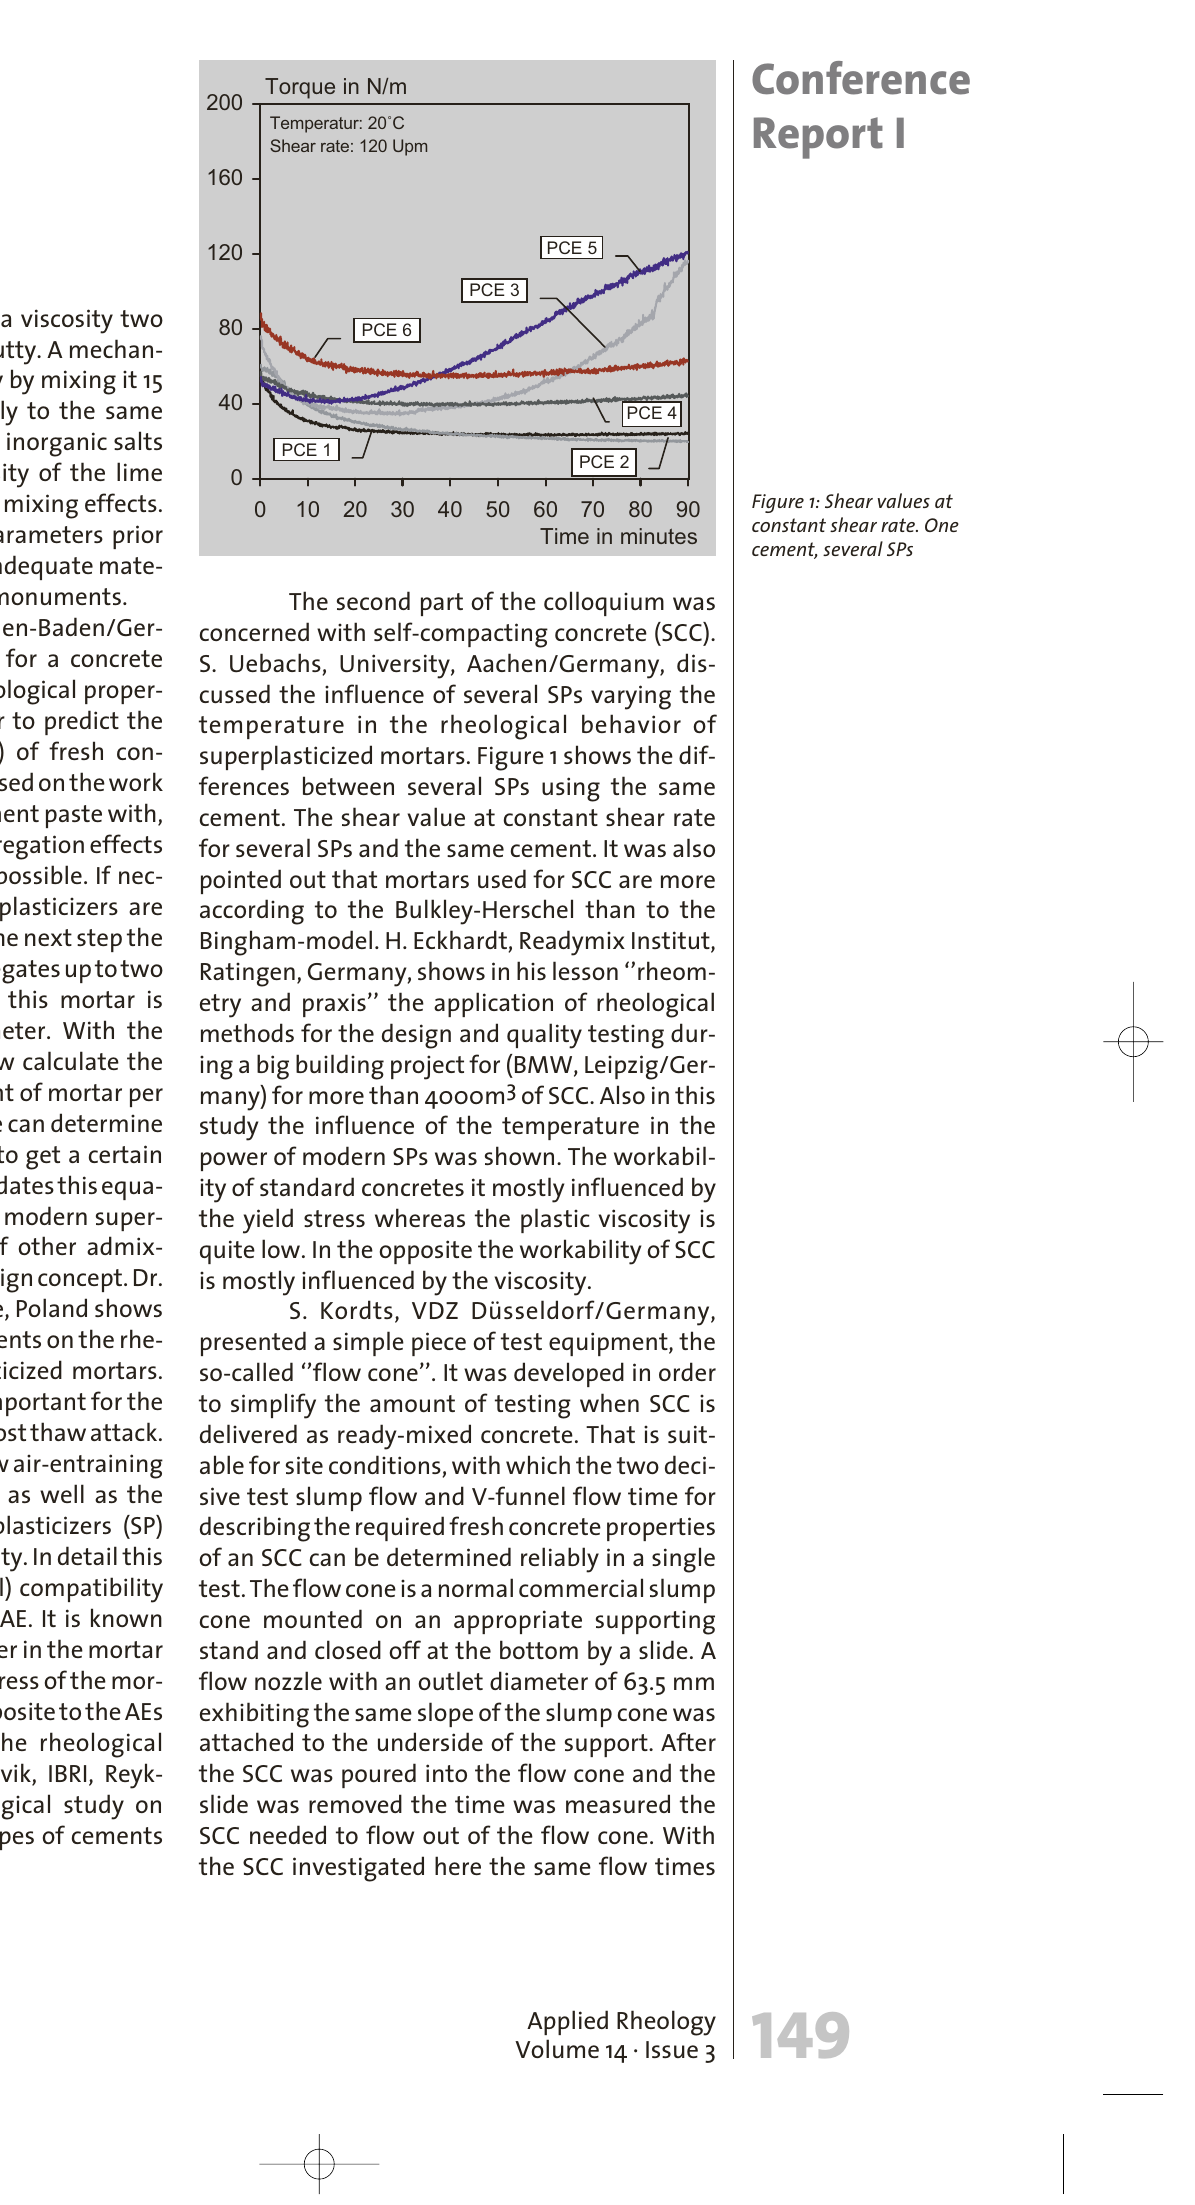
Figure 1: Shear values at constant shear rate. One cement, several